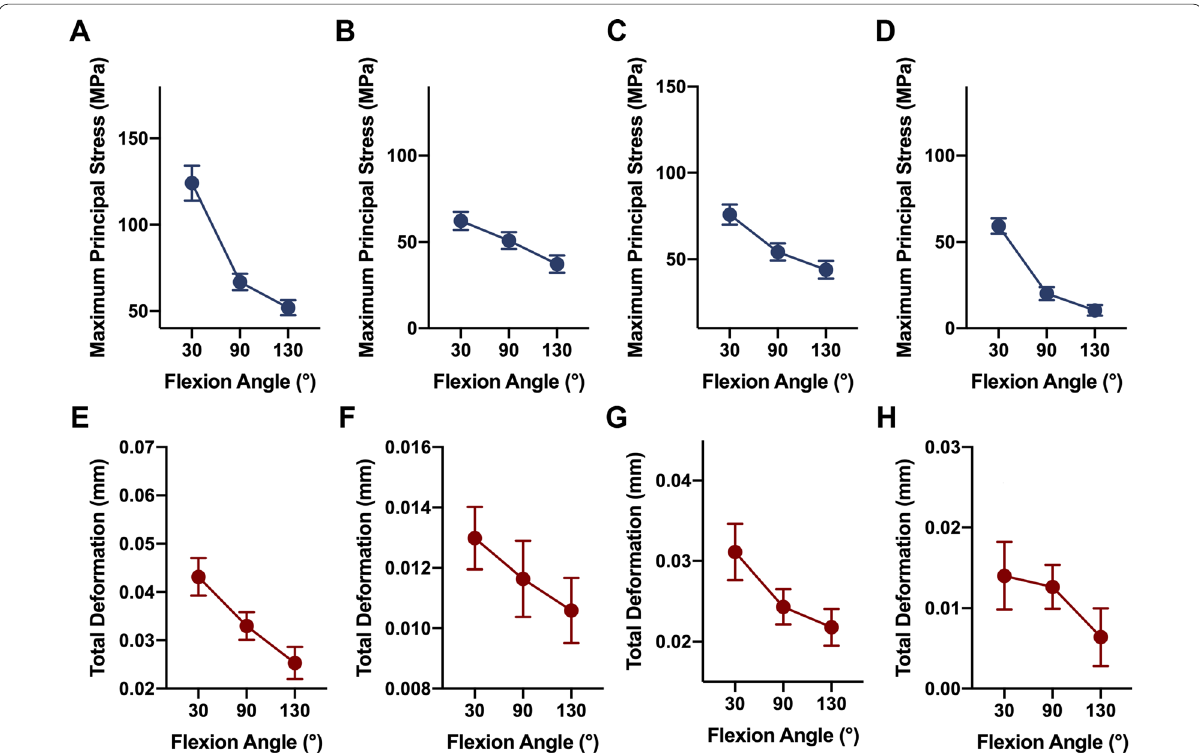
Fig. 7 The effect of flexion angle on the maximum principal stress and the maximum deformation. A , E The maximum principal stress and the maximum deformation both significantly decrease as the elbow flexion angle increases when using a double 2.0‑mm fixation bolt. B , F The maximum principal stress and the maximum deformation both significantly decrease as the elbow flexion angle increases when using a double 2.5‑mm fixation bolt. C , G The maximum principal stress and the maximum deformation both significantly decrease as the elbow flexion angle increases when using a single 4.0‑mm fixation bolt. D , H The maximum principal stress and the maximum deformation both significantly decrease as the elbow flexion angle increases when using a single 4.5‑mm fixation bolt. Data shown are the mean and SD.